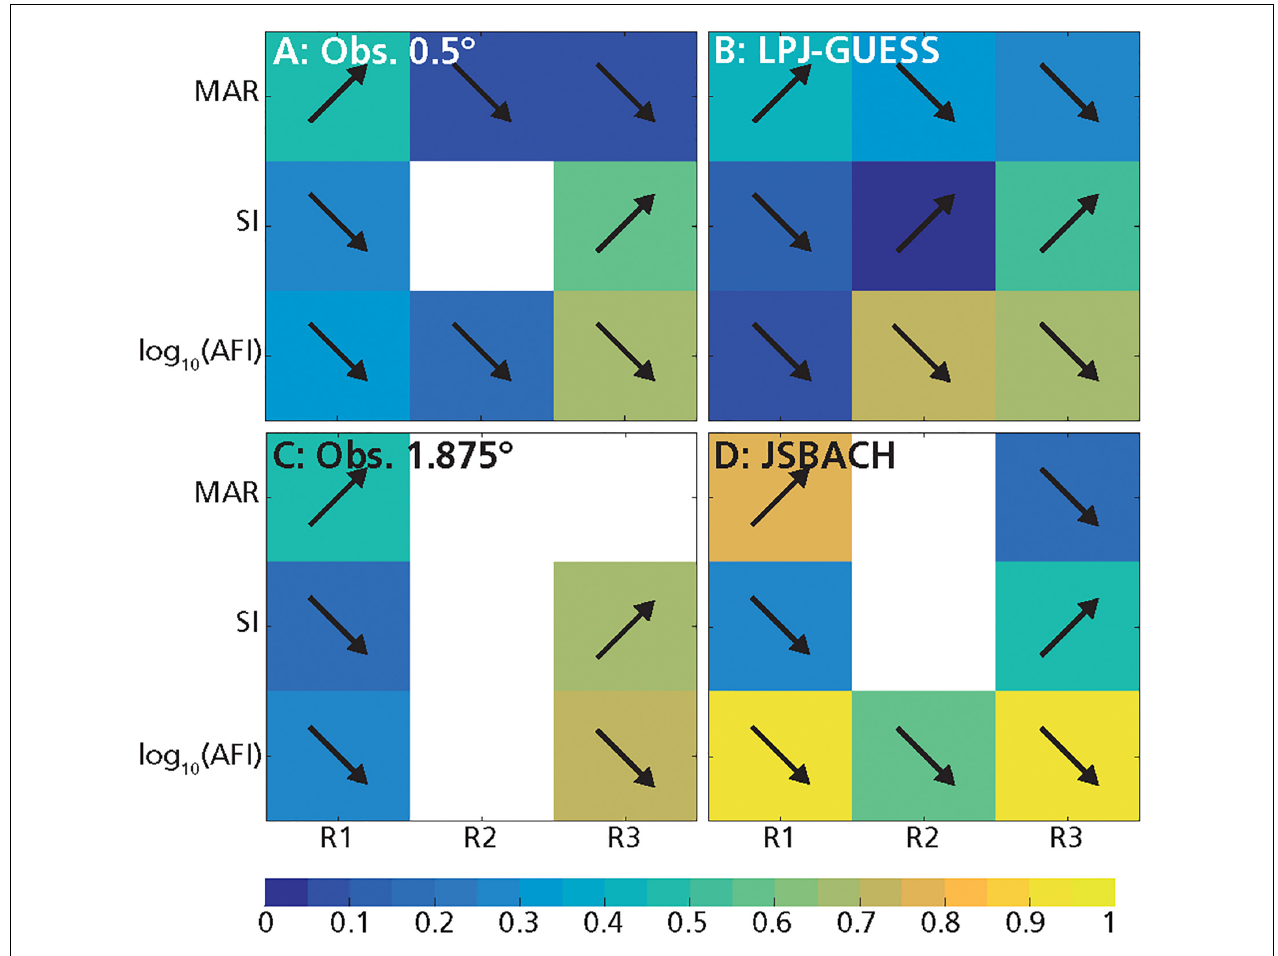
FIGURE 7 | Same as Figure 6 but for grass